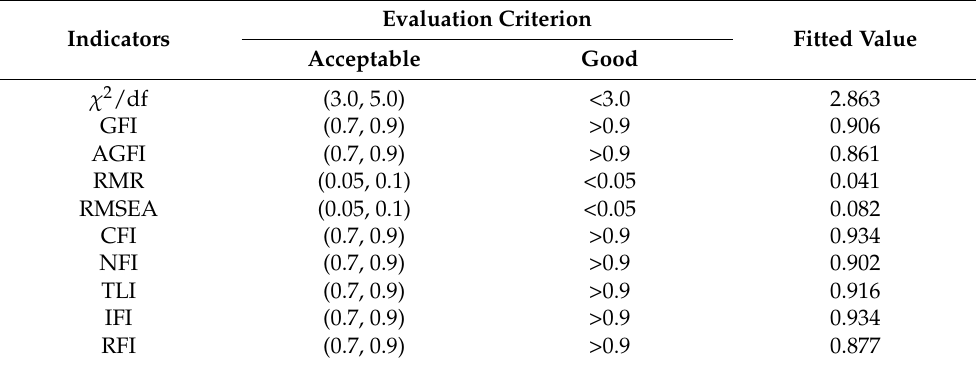
Table 5. Fitting effect of the model.